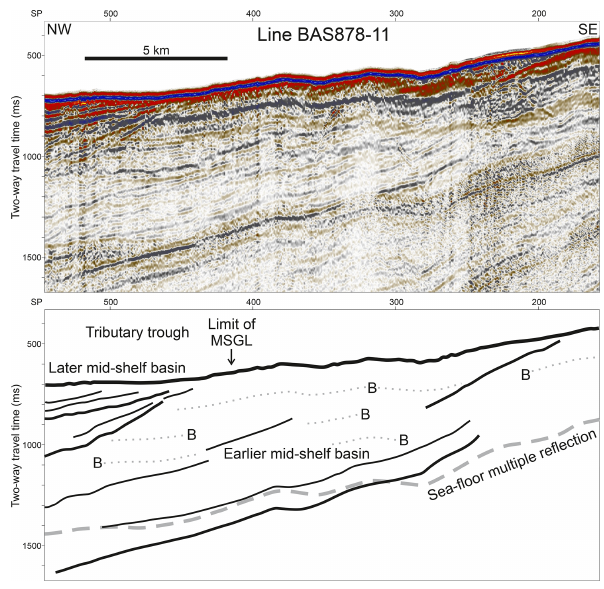
Figure 7. Part of MCS Line BAS878-11 and interpreted line draw- ing, showing the entire area of the confluence between Anvers- Hugo Trough and a tributary trough is underlain by sedimentary strata, and that the lateral limit of MSGL in the tributary trough lies within 1km of the position where a unit of younger strata with a distinct seismic facies character pinches out. An f-k demultiple pro- cess was used to suppress the sea-floor multiple reflection on this line. Dotted grey lines labelled B on the line drawing mark promi- nent bubble pulse reverberations following the sea-floor reflection. Location of profile shown in Fig.